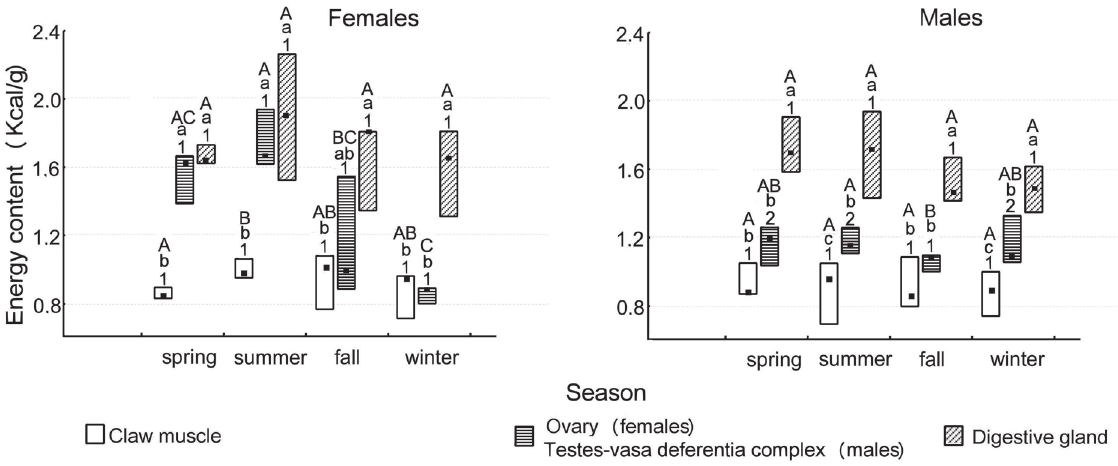
Fig . 3. – seasonal energy content in different organ/tissues of female (left) and male (right) Platyxanthus patagonicus . squared marks: me- dian; box: range. Different/equal capital letters on top of the box plots represent significant/non-significant differences (Kruskal Wallis test, P<0.10 and t statistic test comparisons between pairs of treatments, P<0.05) between seasons for each combination of organ/tissue and sex; different/equal lower-case letters represent significant/non-significant differences (Kruskal Wallis test, P<0.10 and t statistic test comparisons between pairs of treatments, P<0.05) between organs/tissues for each combination of season and sex; Different/equal numbers represent significant/non-significant differences (mann and Whithney u test, P<0.05) between sexes for each combination of organ/tissue and